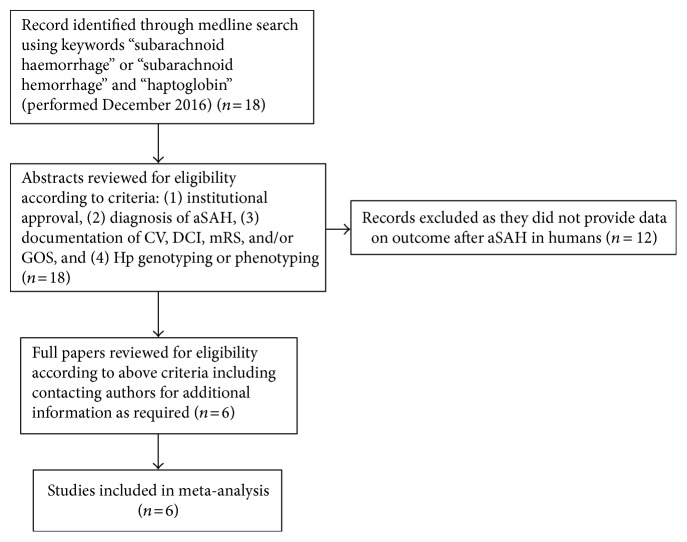
Flow diagram of studies selected for inclusion. If additional information was required, the authors were contacted by email.